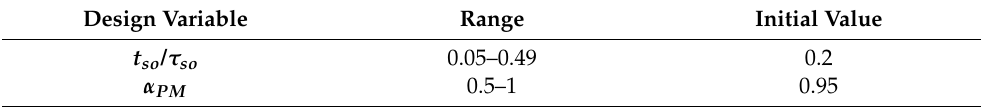
Table 4. Initial value and variation range of the design